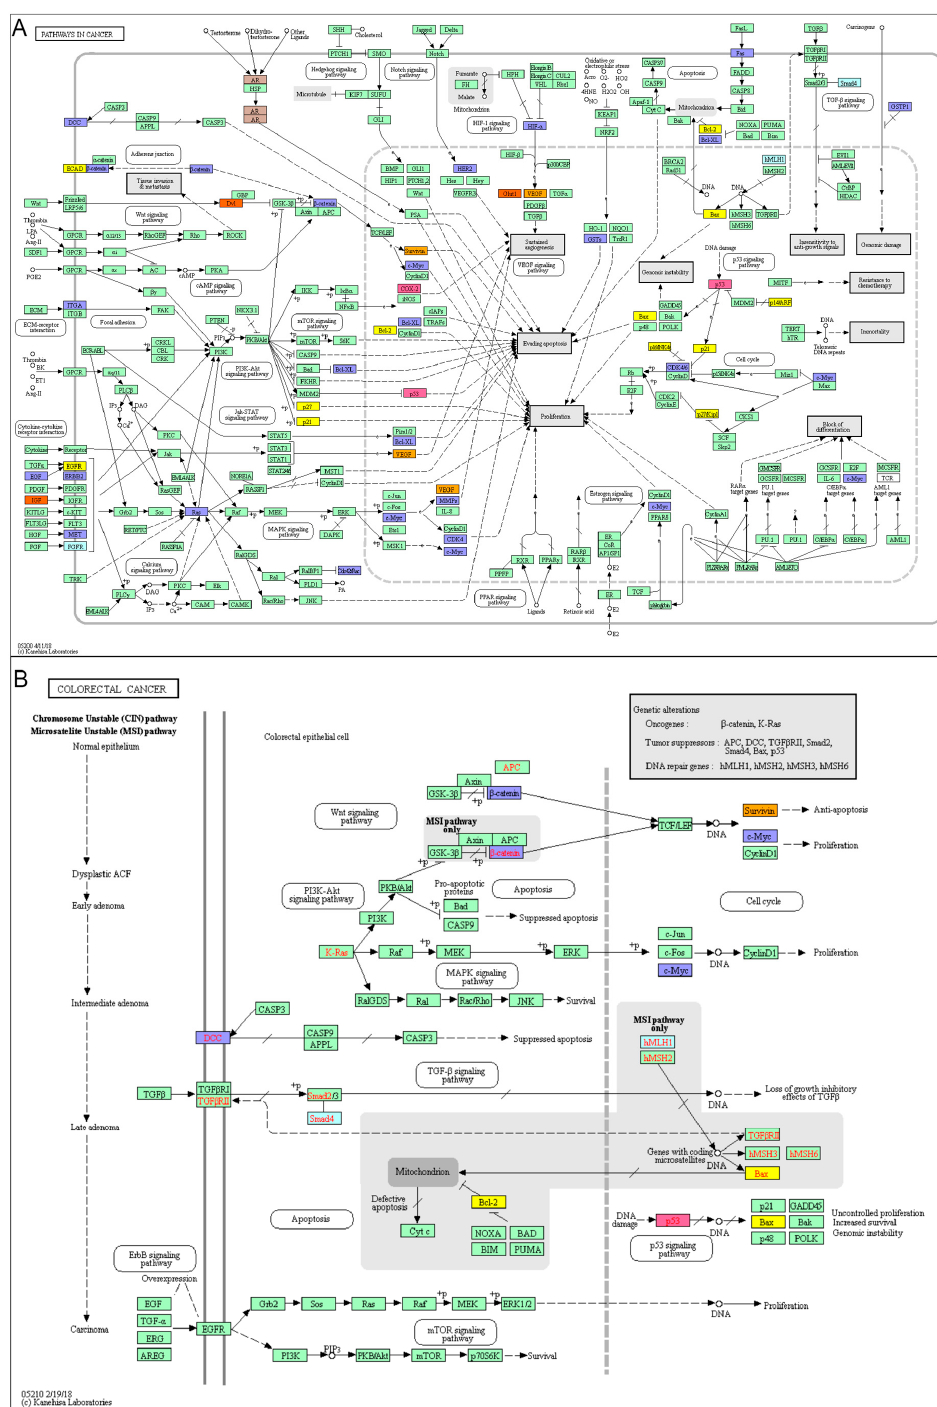
Figure 3. Biomarkers in the Pathways in cancer. ( A ) Various cancer pathways involve in different cancer initiation and progression. ( B ) CRC biomarkers for diagnosis, therapy and prognosis biomarkers in the CBD were mapped in different colours in Pathways in cancer. The CRC biomarkers have been associated with apoptosis, cell proliferation, VEGF signalling pathway and Ras signalling pathway in the Pathways in cancer. Red: diagnosis biomarker; Blue: treatment biomarker; Purple: prognosis biomarker; Orange: diagnosis & treatment biomarker; Yellow: treatment & prognosis biomarker; Pink: diagnosis & treatment & prognosis